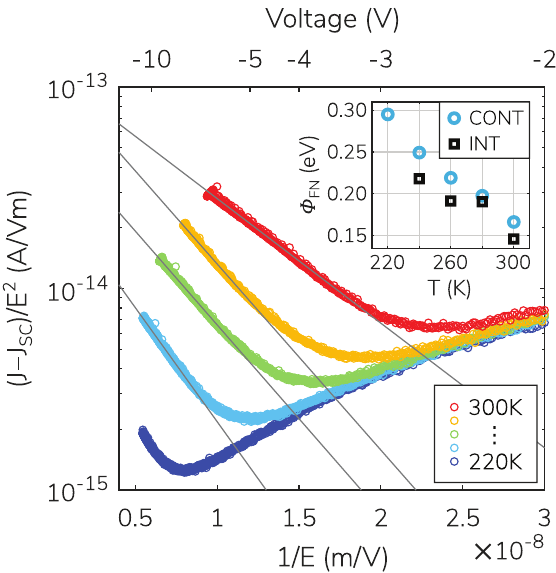
Fig. 5. Fowler-Nordheim analysis of the temperature-dependent IV characteristics measured with intermittent voltage sweeps that were shown in Figure 3. The lines show linear fi ts to the experimental data (coloured circles). The inset shows the Fowler- Nordheim barrier F FN extracted from the linear fi ts for both continuously and intermittently measured data.